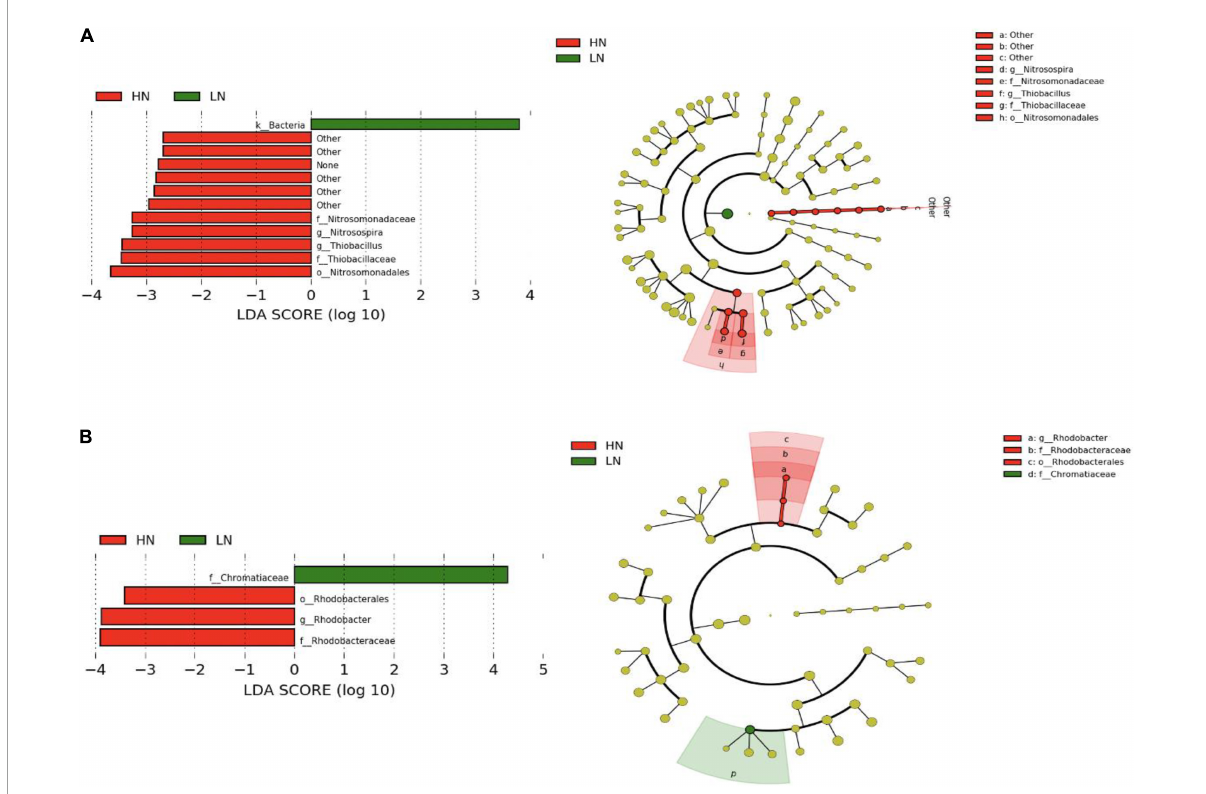
FIGURE7 Differentially abundant CO 2 -fixing bacterial taxa as assessed using a histogram of linear discriminate analysis (LDA) and cladogram of phylogenetic distribution with effect size measurements (LEfSe) in the Huixian karst groundwaters. (A) cbbL gene; (B) cbbM gene.